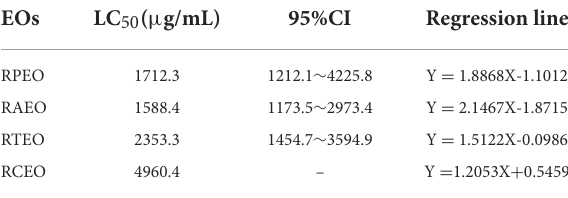
TABLE 3 The acaricidal activity of the essential oils from four Rhododendron